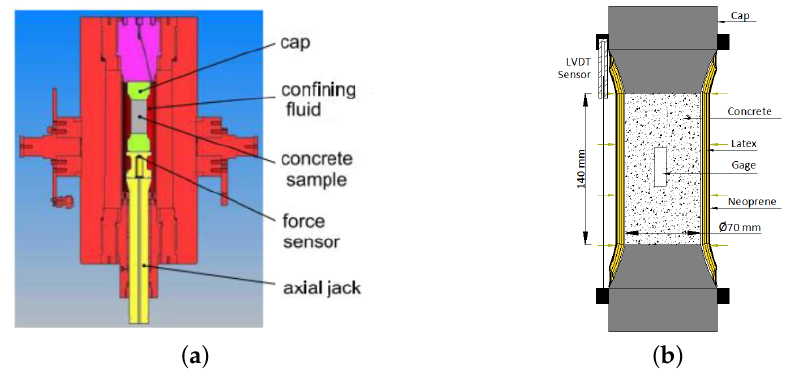
Figure 1. Giga press: ( a ) confining cell cross section; and ( b ) sample protection and